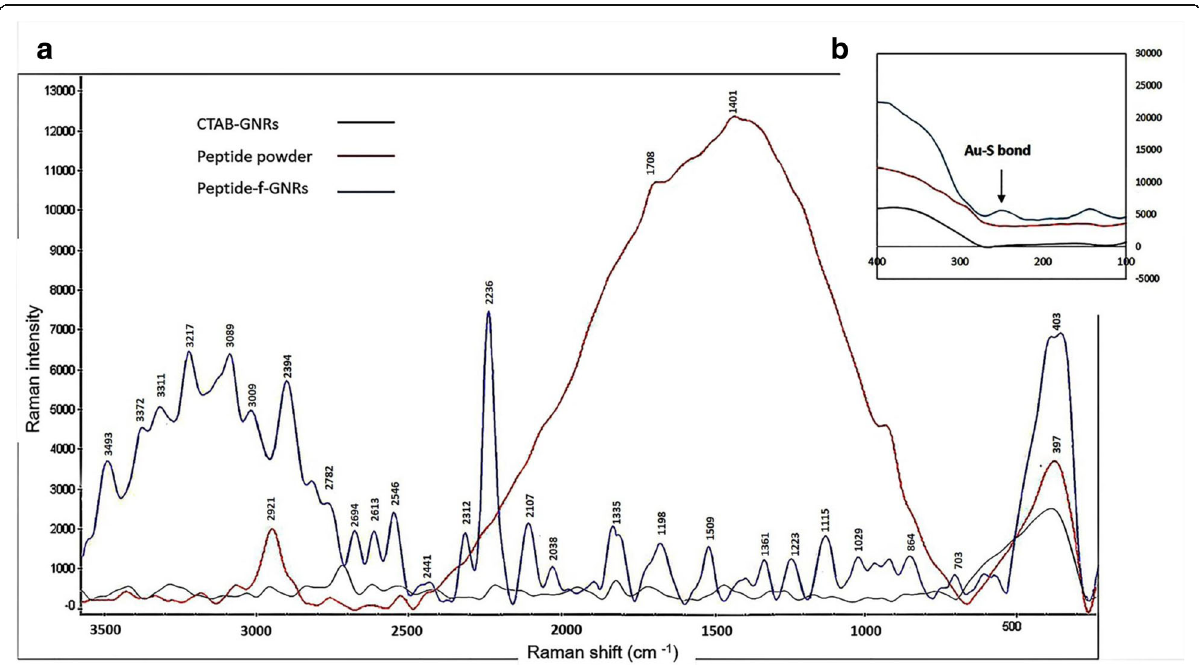
Fig. 3 FTIR spectra of peptide-f-GNRs compared to CTAB-GNRs and peptide powder